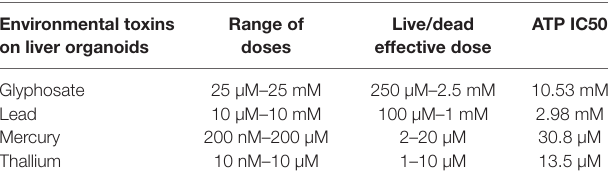
TaBle 1 | Summary of the effects of the environmental toxins on liver spheroids. environmental toxins range of on liver organoids